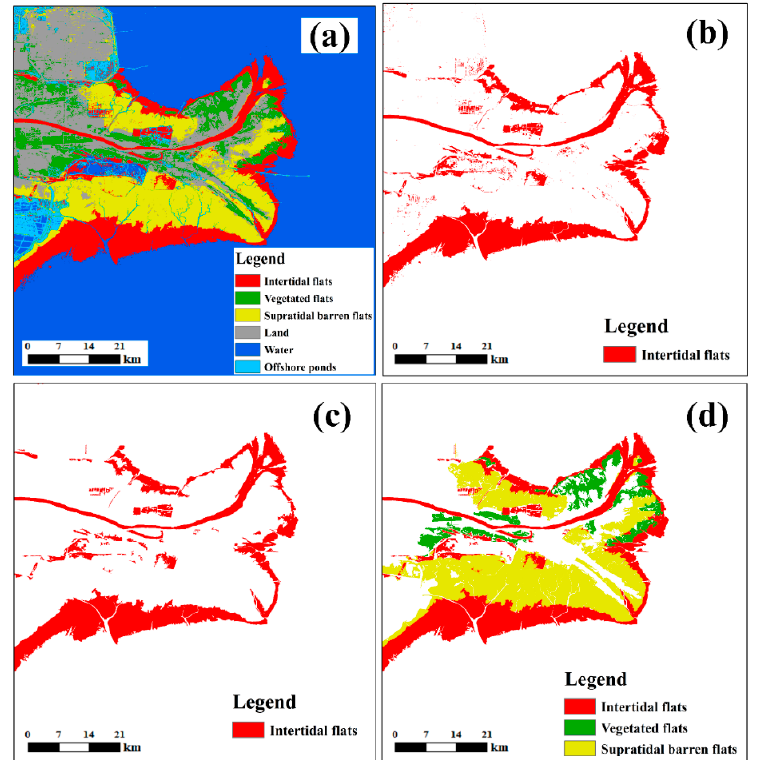
Figure 7. Example of morphological process for tidal flats mapping: ( a ) is the preliminary result from GEE in collaboration with random forest algorithm, ( b ) manifests intertidal flat patches after using the kernel of eight-connected neighbors, ( c ) is the result filtered by minimum pixels count, and ( d ) is final map generated from the iterative eight-connected kernel and manually revised.